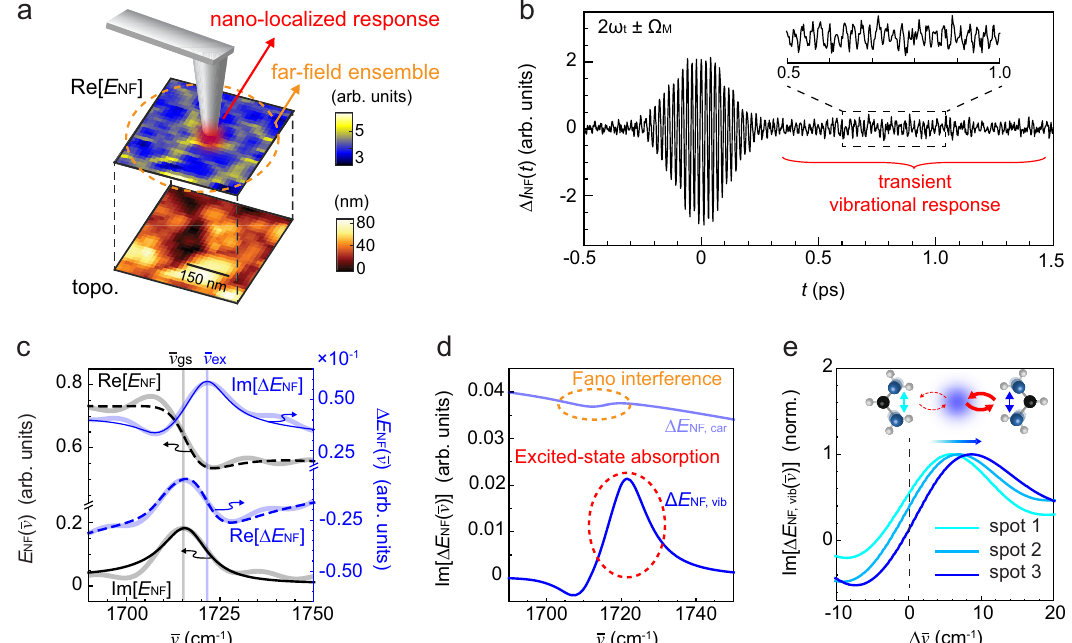
Fig. 5 Transient vibrational nano-spectroscopy of FAMACs perovskite. a Ground-state IR s -SNOM Re ½ E NF (cid:5) imaging (top) and AFM topography (bottom). b HPP IR s -SNOM interferogram Δ I NF ( t ) acquired at T = 2 ps with instantaneous polaron absorption and long-lived transient vibrational coherence. c Phase- and frequency-resolved nano-localized pump-probe Δ E NF ð ν Þ and ground-state response E NF ð ν Þ . d Decomposition of Im ½ Δ E NF ð ν Þ(cid:5) into the transient vibrational (Im ½ Δ E NF ; vib ð ν Þ(cid:5) ) and carrier (Im ½ Δ E NF ; car ð ν Þ(cid:5) ) contributions with a minor feature from Fano-type interference. e The nano-localized transient vibrational signal Im ½ Δ E NF ; vib ð ν Þ(cid:5) at different sample locations shows nanoscale spatial heterogeneity in the polaron – cation